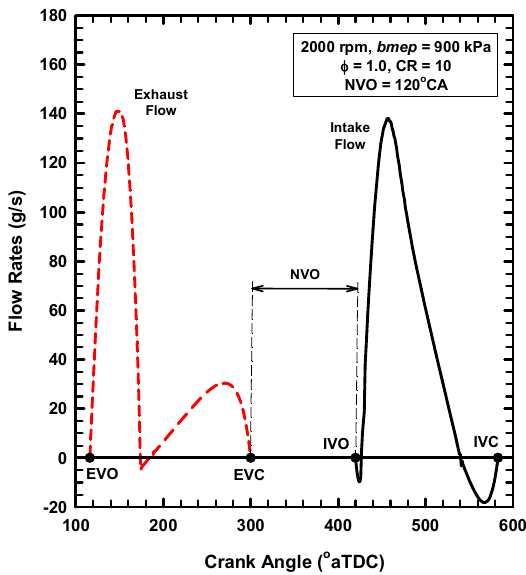
Figure 20. Exhaust and intake mass flow rates as functions of crank angle for a NVO of 120 °CA for case 1.